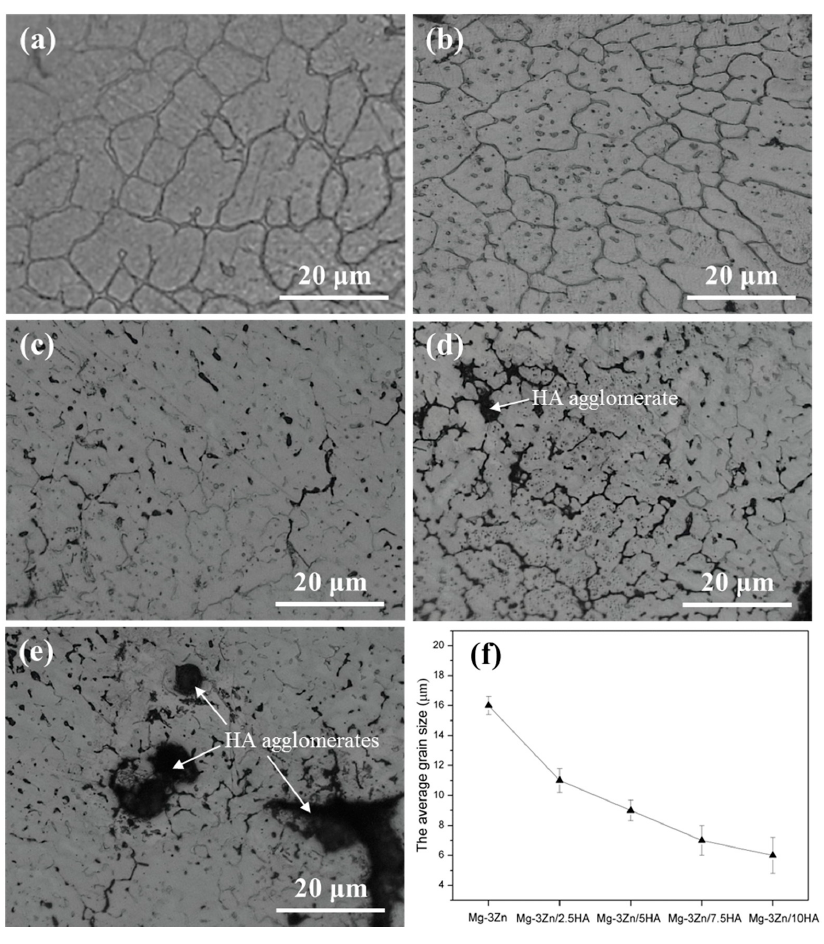
Figure 1. The crystal structure of the Mg-3Zn/ x HA composites: ( a ) Mg-3Zn alloy; ( b ) Mg-3Zn/2.5HA; ( c ) Mg-3Zn/5HA; ( d ) Mg-3Zn/7.5HA; ( e ) Mg-3Zn/10HA composite and ( f ) their average grain size. Materials 2017 , 10 , 307